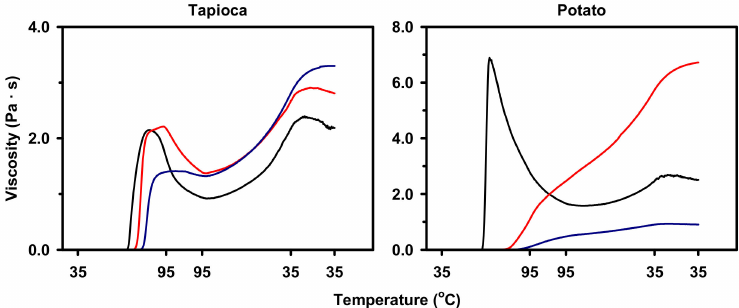
Figure 5. Pasting profiles of native ( — ) and heat–moisture treated starches: 0-min holding time with 1 iteration ( — ) and 60-min holding time with 6 iterations ( —